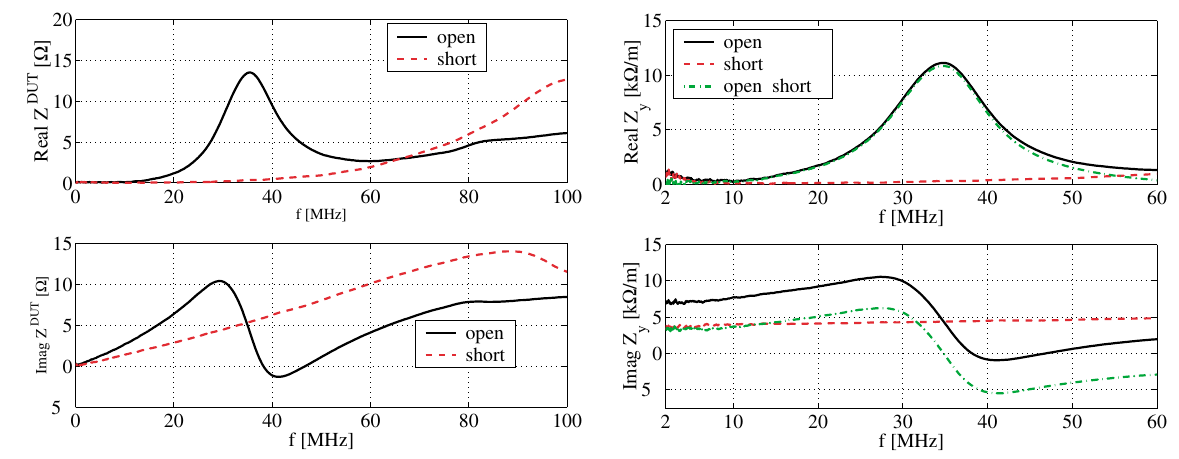
FIG. 5. (Color) Measured kicker impedances, Z DUT (left panel) and Z terminations at the